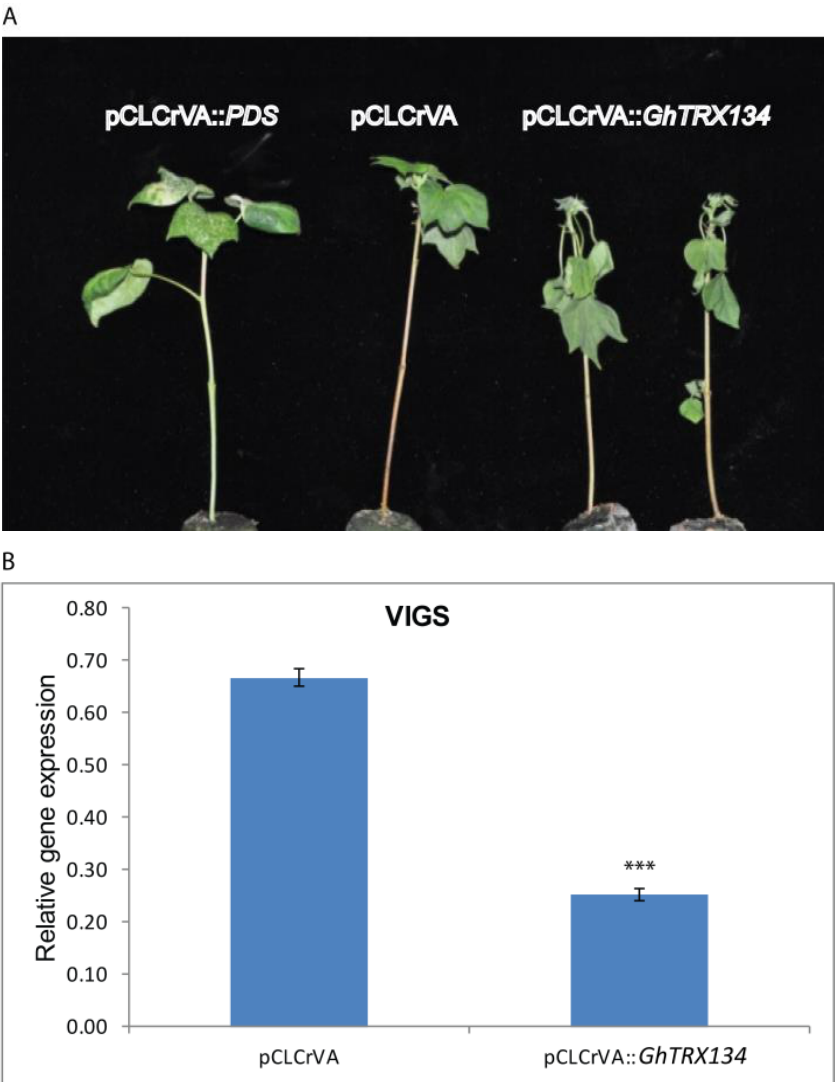
Figure 5. Silencing of GhTRX134 using the pCLCrVA-pCLCrVB system inhibited tolerance to drought in cotton plants. ( A ) The phenotypes of the virus-infected cotton seedlings pCLCrVA:: GhTRX134 , the control pCLCrVA plants, and the pCLCrVA::PDS indicator plants. ( B ) The expression of GhTRX134 in the virus-infected plants and the control (pCLCrVA) plants was examined by qRT-PCR. The values represent the means of three replicates ± SD. Student’s t -test was used to determine the significant differences (*** p < 0.001) compared to the control plants.